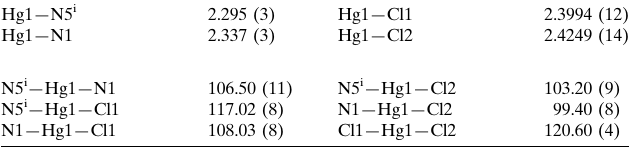
Selected geometric parameters (A˚ , (cid:2) ).